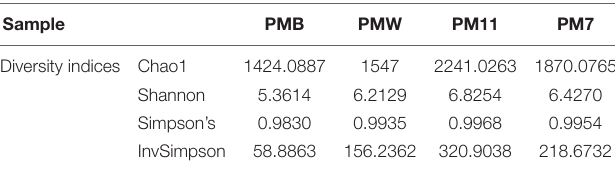
TABLE 2 | Diversity indices of crust (PMW and PMB) and sediment samples (PM7 and PM11) in Muierilor